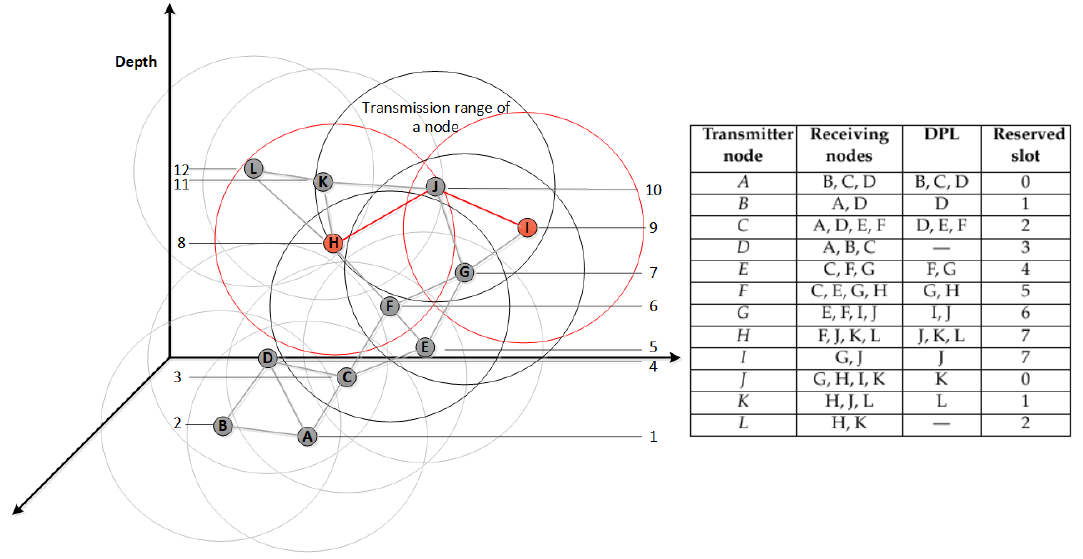
Figure 5. An example of depth-based scheduling in ED-MAC along with the scheduling